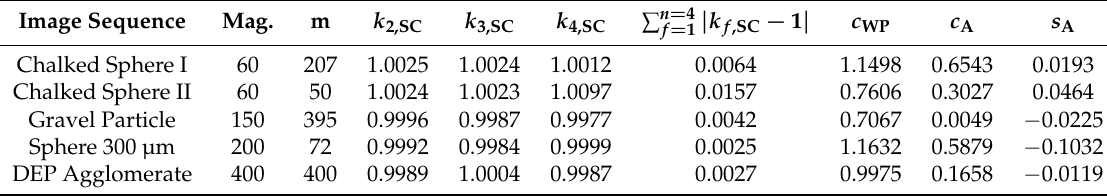
Table 4. Scaling factors for the images of the considered sequences given by the scaled orthographic (SC) factorization method and the deviations to the orthogonal projection scenario. Intrinsic parameters c and s provided by the cost functions for the weak perspective (WP) and general affine (A) camera. Image Sequence